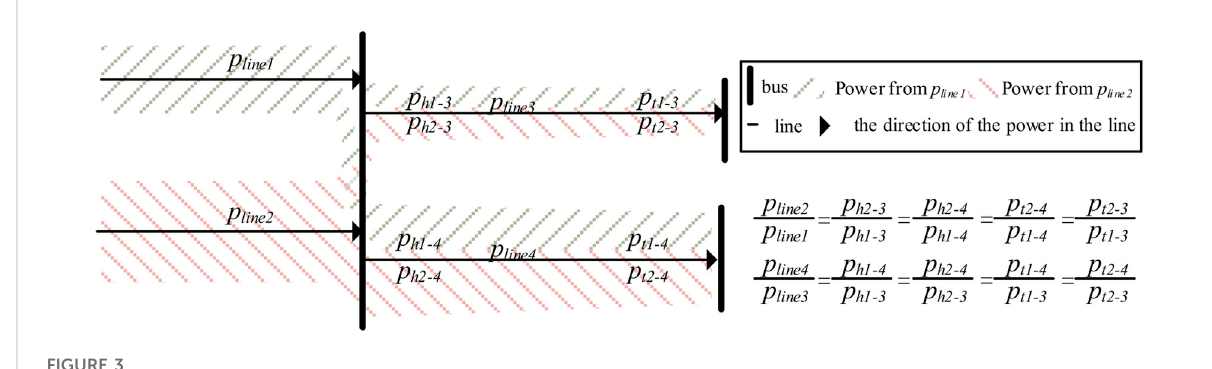
FIGURE 3 Schematic diagram of the proportion sharing